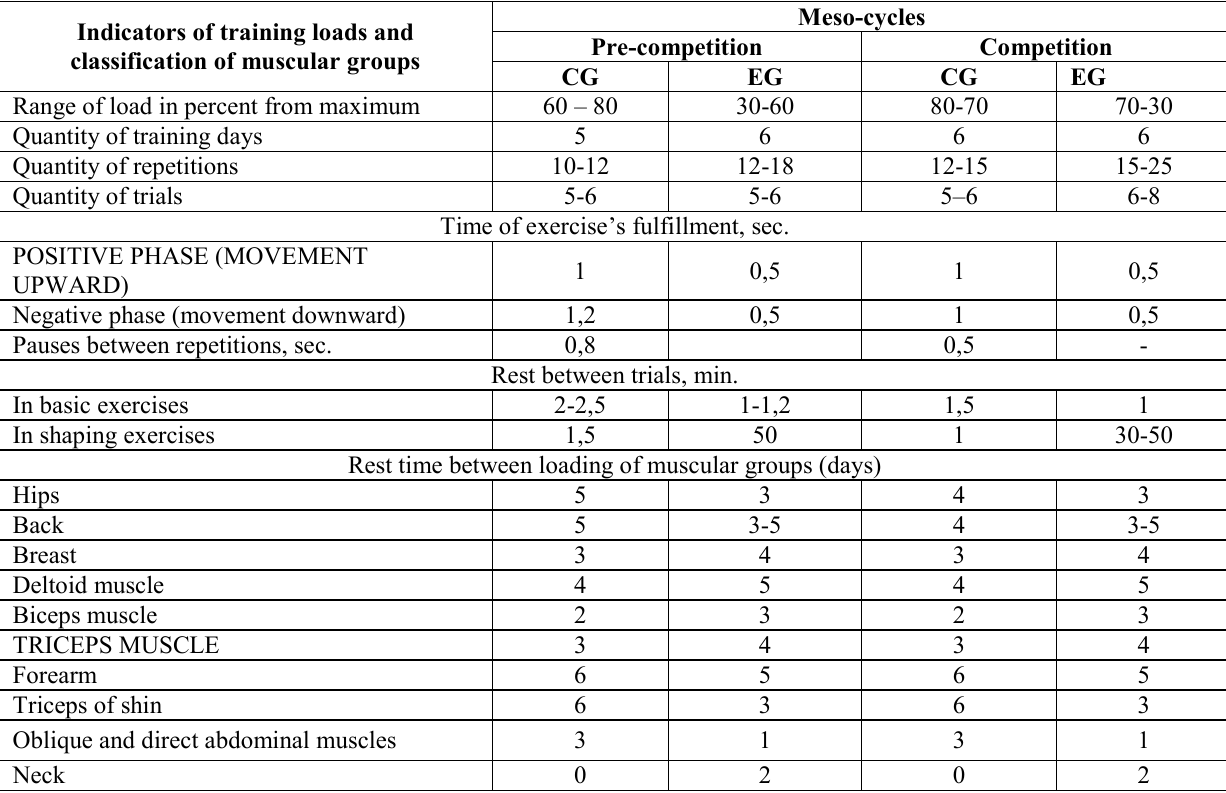
Content of training program depending on mass of load in competition period of qualified bodybuilders (experimental and control